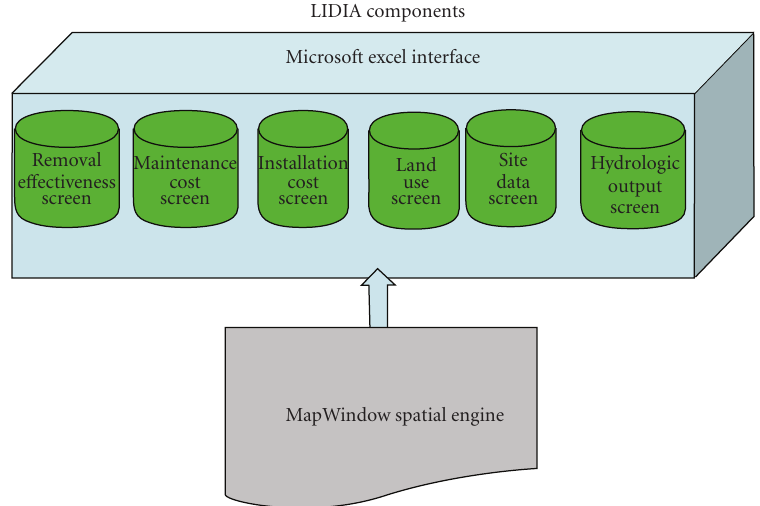
Figure 15: Low-Impact Development Implementation Assessment.